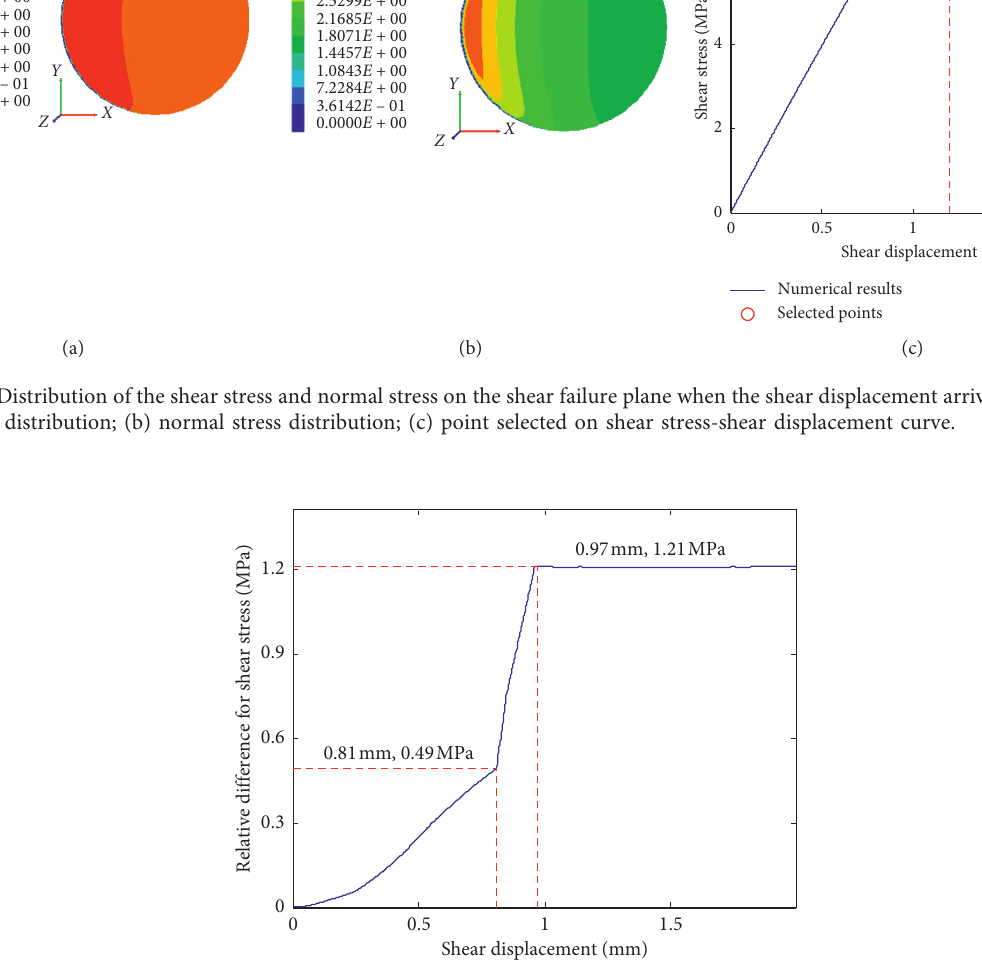
Figure 16: Variation of the relative difference of shear stresses in the numerical test.